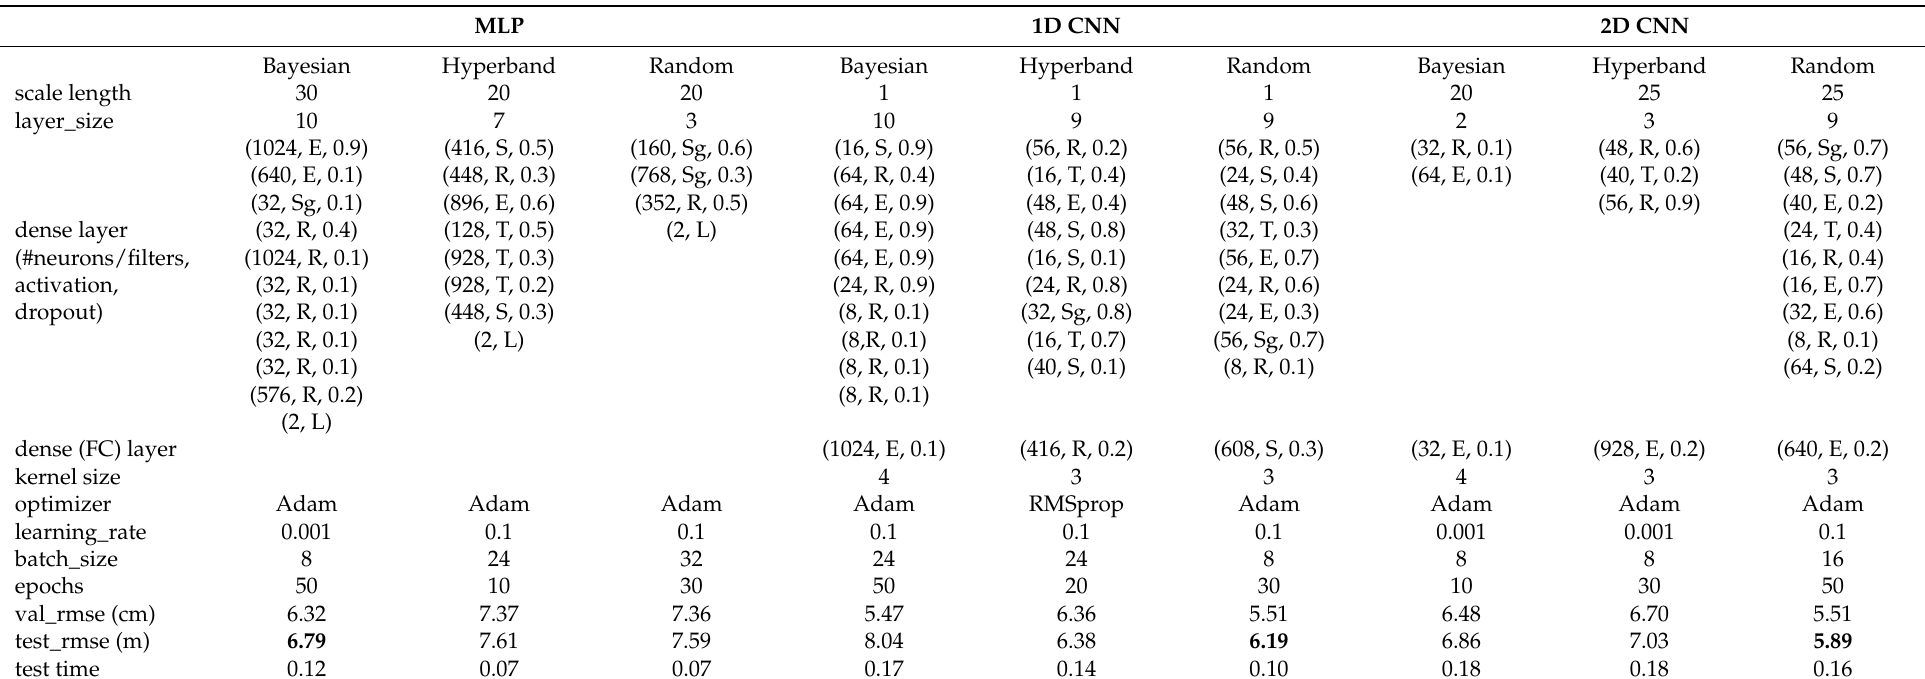
Table 2. MLP, 1D CNN, and 2D CNN first stage HPO results with validation and test scores. MLP 1D CNN 2D